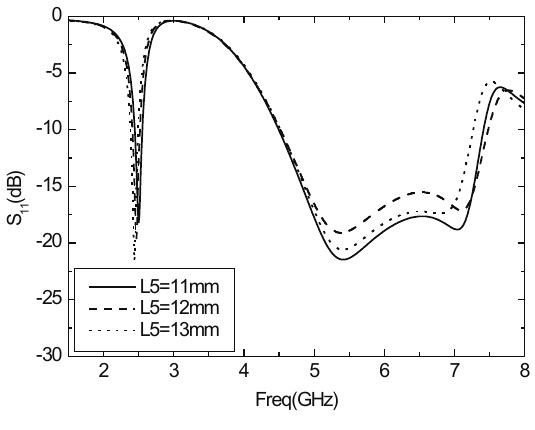
Figure 7. Parameter S 11 varies with